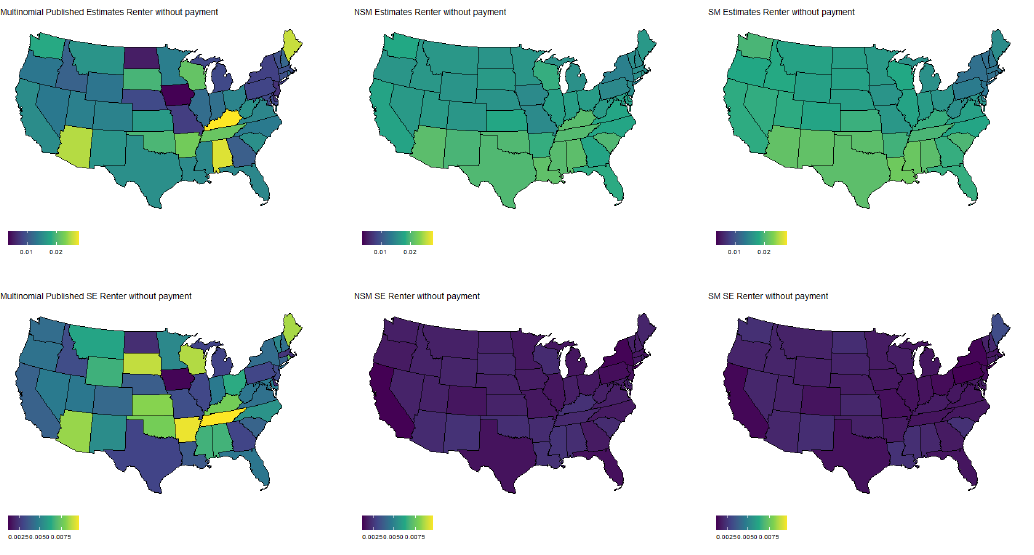
Figure 7. Estimated population proportion of people who rent but cannot pay by state and estimator along with corresponding standard error in Week 1 of the Household Pulse Survey. Estimates are plotted on the same color scale, and SEs are plotted on another color